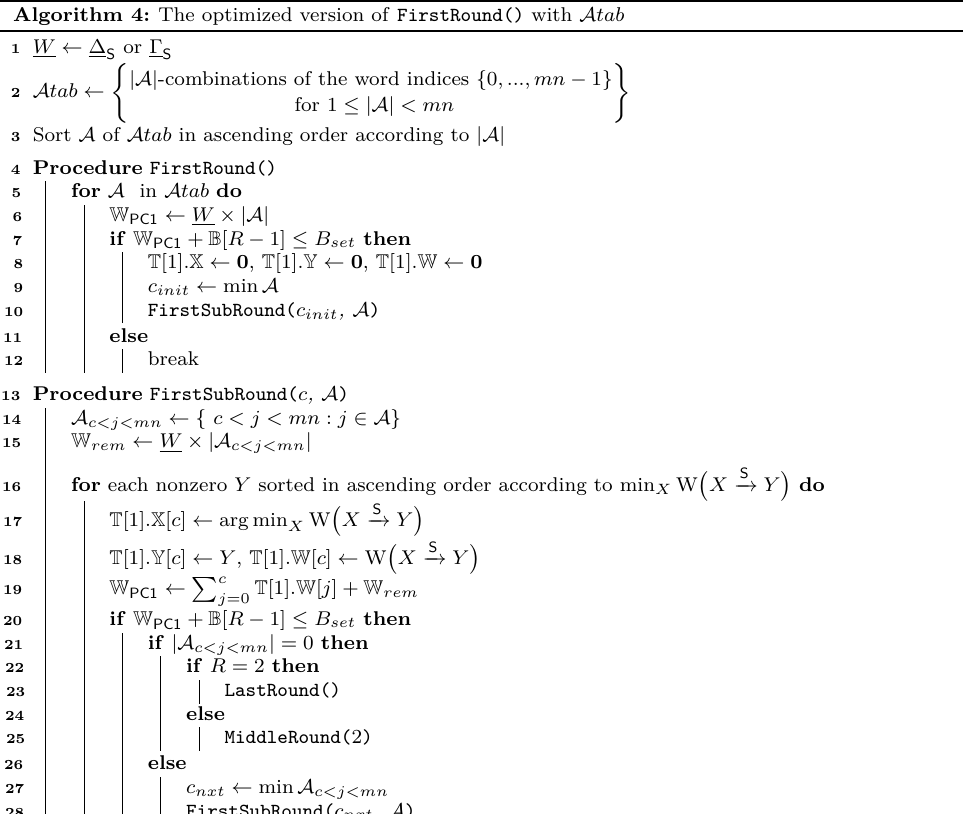
Algorithm 4: The optimized version of FirstRound() with A